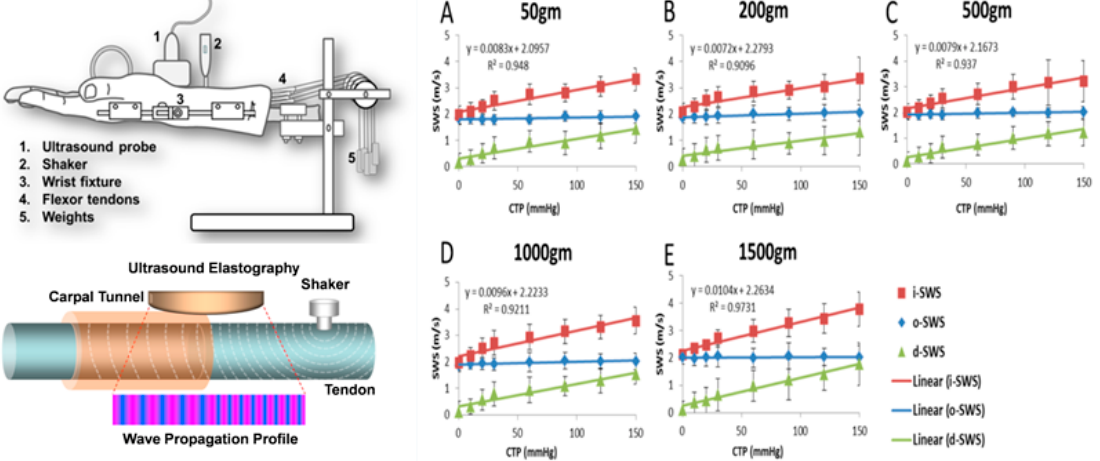
Figure 5. Shear wave elastography for the estimation of carpal tunnel pressure. Left top and bottom figures show the experimental setting and ultrasound elastography measure of third digit FDS tendon. ( A – E ) demonstrate the wave speed of the tendon within and outside carpal tunnel region. Reprinted from [70].